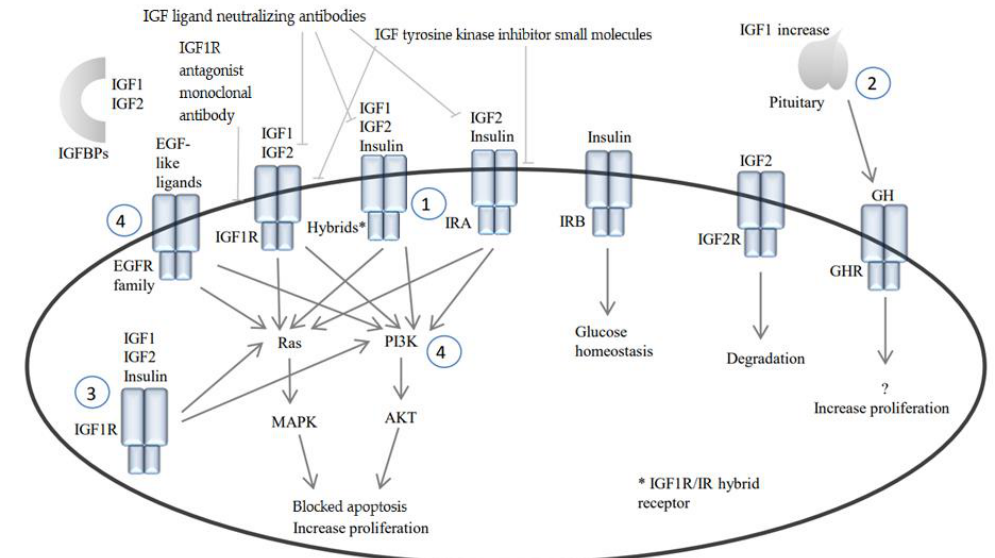
Figure 1. IGF and insulin signaling. Receptor hybridization, activation and downstream signaling of IGF, insulin and GH receptors. IGF1/2 = insulin-like growth factor-1/2, IGF1R = insulin-like growth factor-1 receptor, IGF2R = insulin-like growth factor 2 receptor or mannose 6-phosphate receptor, IR(A/B) = insulin receptor (A/B), GH = growth hormone, GHR = growth hormone receptor, EGF = epidermal growth factor and EGFR = epidermal growth factor receptor.